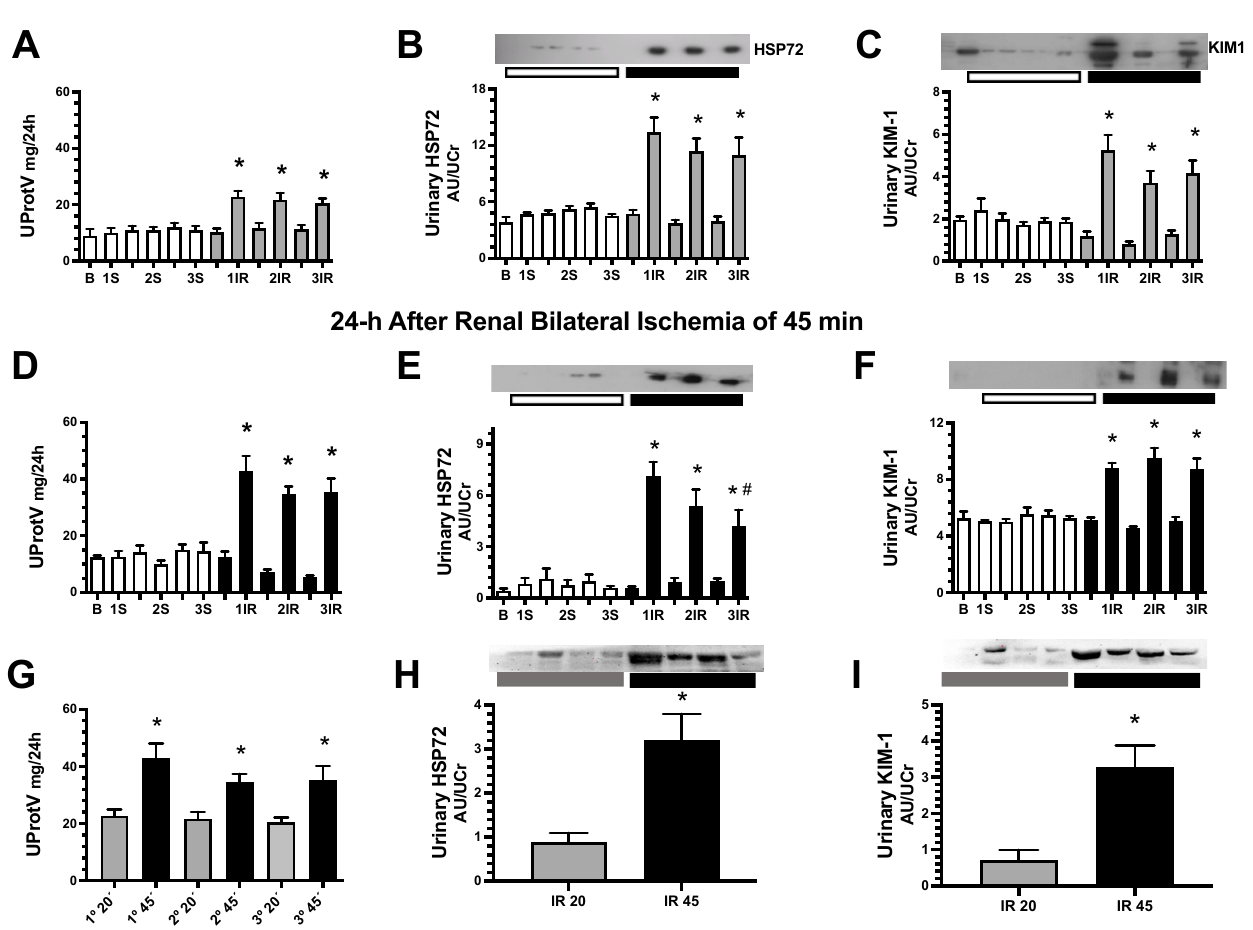
Figure 1. Proteinuria and urinary renal injury biomarkers measured before and 24 h after every AKI episode. In ( A – C ) are the results obtained from a mild and in ( D , E ) from a severe ischemic insult. ( A , D , G ) Urinary protein excretion, ( B , E , H ) urinary HSP72 and ( C , F , I ) urinary KIM1 assessed by WB analysis and corrected by urinary creatinine. Sham groups are represented in white bars, IR 20 min groups in gray bars and IR 45 min groups in black bars. Evaluations were performed at baseline ( B ), 24 h after each surgery (1S, 2S, 3S or 1IR, 2IR, 3IR) and two days before subsequent surgery (bars between surgeries). In ( G , H , I ), the renal injury provoked by 20 or 45 min of renal ischemia are compared. n = 6 to 10 per group. * p < 0.05 vs. sham group; # p < 0.05 vs.